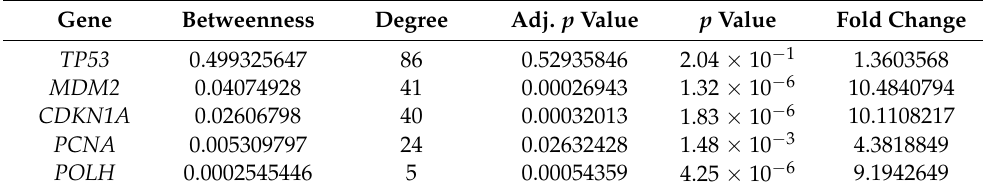
Figure 3. PPI network of 250 top differently expressed genes between cisplatin resistant vs. parental A549 cells. The PPI pairs were imported and visualised by Cytoscape software. Table 2. Top 5 networking DEGs involved in cisplatin resistance—upregulated in cisplatin-resistant A549 cells. Fold change—A549 cisplatin-resistant vs. A549 parental, degree—presents the number of undirected